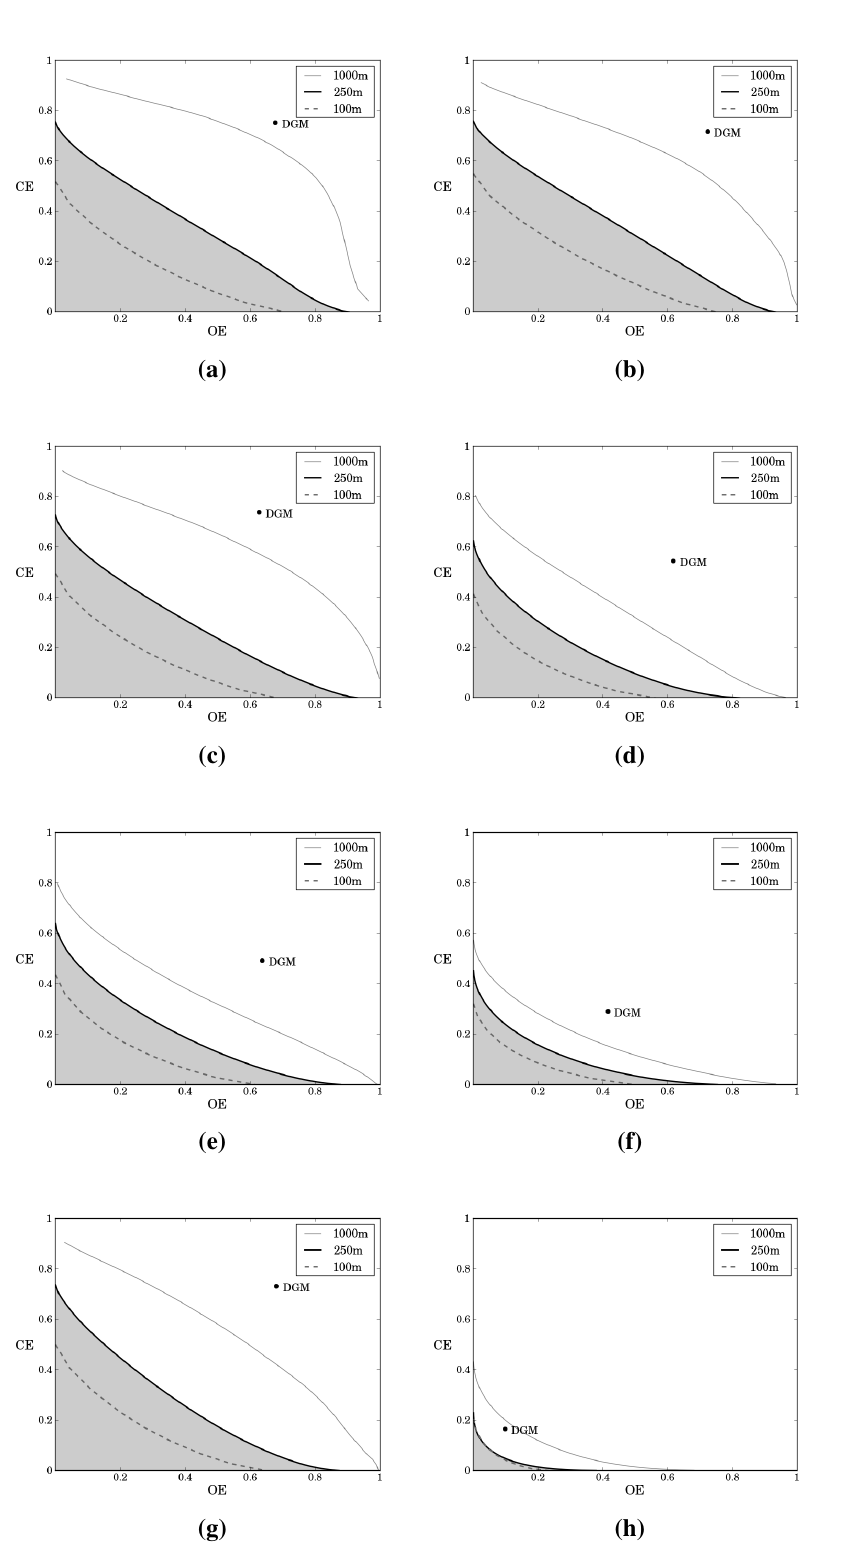
Figure 6. Pareto boundaries for the eight reference maps and the simulated boundaries for the SPOT-VEGETATION (1000 m), MODIS (250 m) and PROBA-V(100 m) sensors. In the current 250-m product, the unreachable region accounts for up to 60% of the errors. ( a ) Atar, dry season; ( b ) Atar, rainy season; ( c ) Tidjikja, dry season; ( d ) Tidjikja, rainy season; ( e ) Aleg, dry season; ( f ) Aleg, rainy season; ( g ) Nema, dry season; ( h ) Nema, rainy